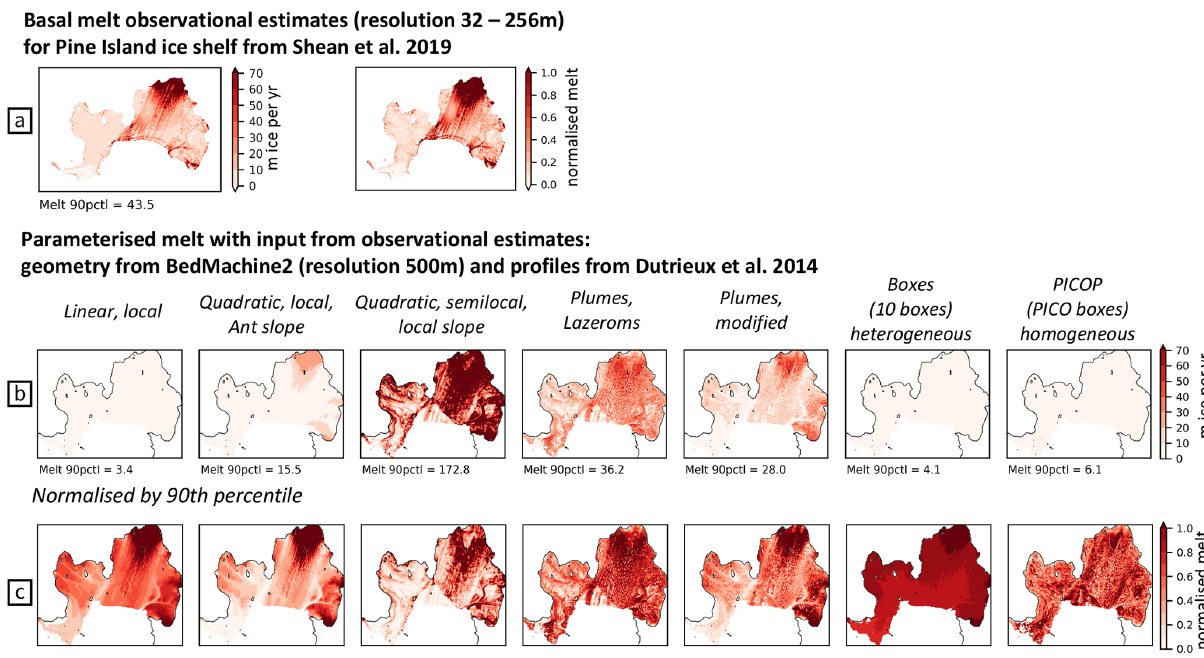
Figure 8. Comparison between (a) observational estimates inferred from remote sensing and (b) parameterised melt rates inferred for the Pine Island Glacier ice shelf based on observational estimates of input properties and topography and the best-estimate tuned parameters. (c) Parameterised melt rates normalised by dividing by the 90th percentile. The observational estimates of basal melt rates (mean over 2008– 2015) were inferred by Shean et al. (2019) using satellite and airborne altimetry with an initial-pixel method (see Fig. 7b in Shean et al., 2019). The input temperature and salinity are from Dutrieux et al. (2014) and cover 6 years (1994, 2000, 2007, 2009, 2010, 2012). The BedMachine Antarctica version 2 dataset (Morlighem, 2020; Morlighem et al., 2020) is used for the geometric information. We averaged the parameterised basal melt patterns over the 6 years. “Ant slope” stands for “Antarctic